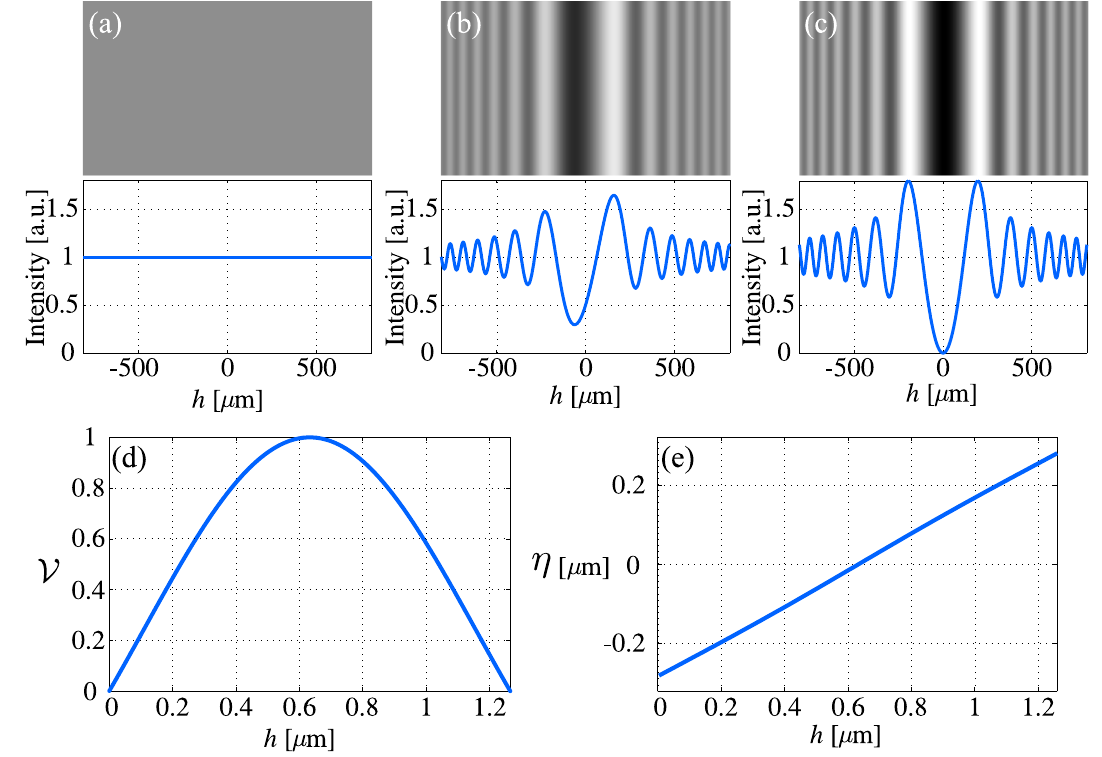
Figure 2. Simulations; Diffraction pattern of a phase step with the height of (a) 0, (b) 0.32 µ m, and (c) 0.63 µ m and their corresponding horizontal cross-sectional profiles. Wavelength is taken as 633 nm. (d) Visibility of the fringes, and (e) extrema position parameter vs. the phase step height variations in one